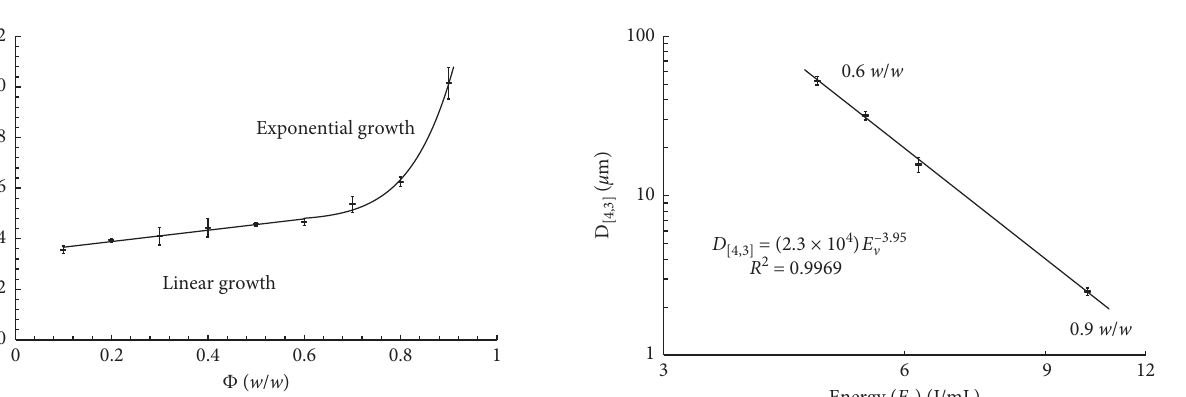
Figure 3: Energy incorporated per volume as a function of the concentration of the dispersed phase for O/W emulsions within a concentration range of 10–90% w / w . Two sections can be found: a linear growth below the 60% w / w threshold and an exponential growth afterwards. The change in the growth can be explained by the decrease in the interdroplet distance which enhances the in- teractions between droplets.